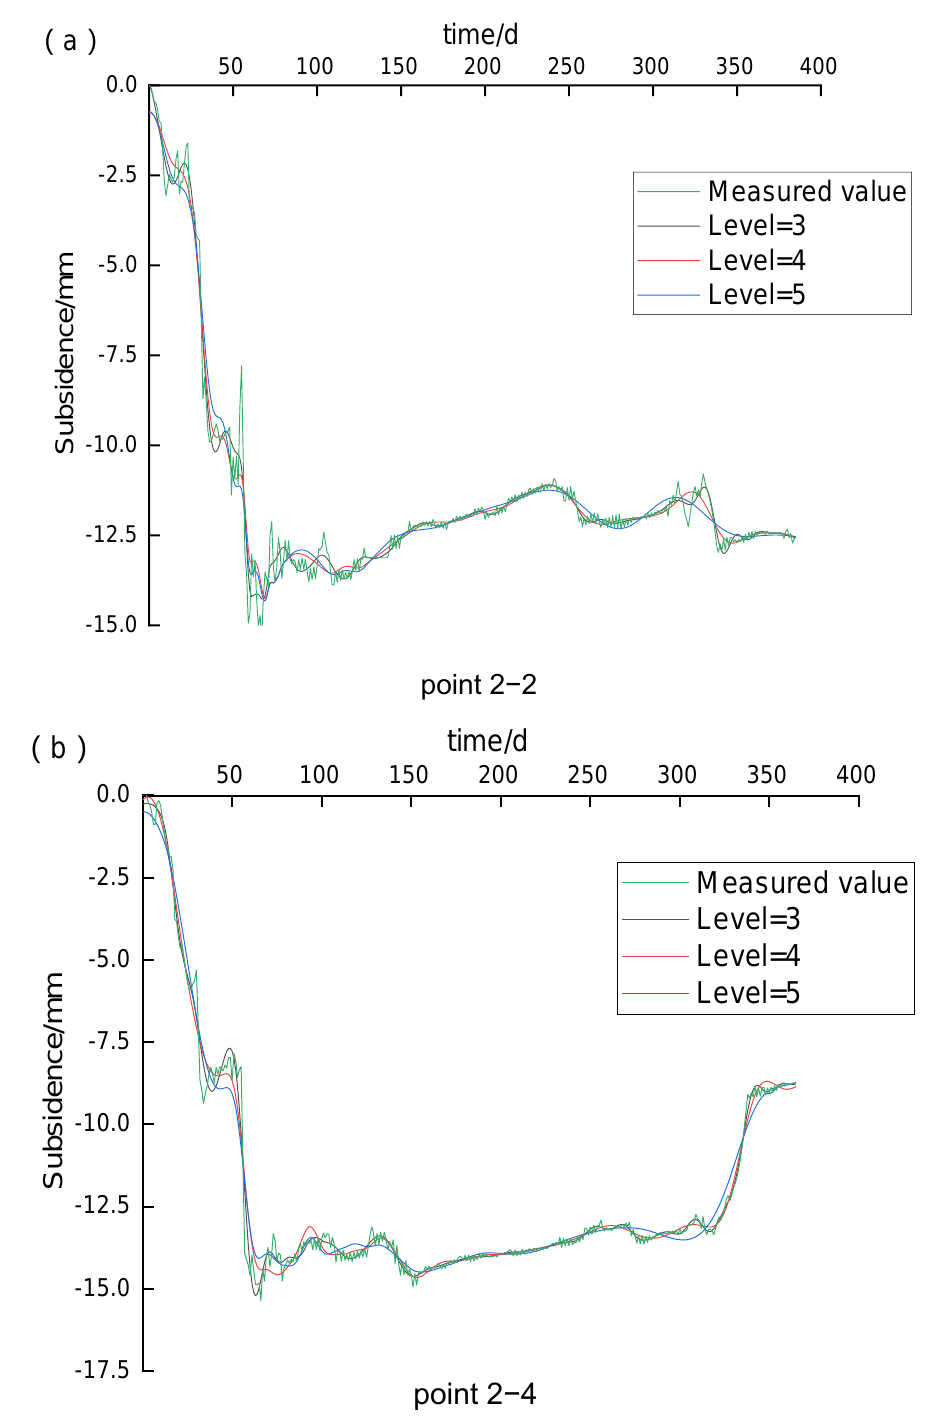
Figure 5. Ground settlements reconstructed from db12 wavelet denoise at different levels ( a ) point 2 − 2 and ( b ) point 2 − 4 .